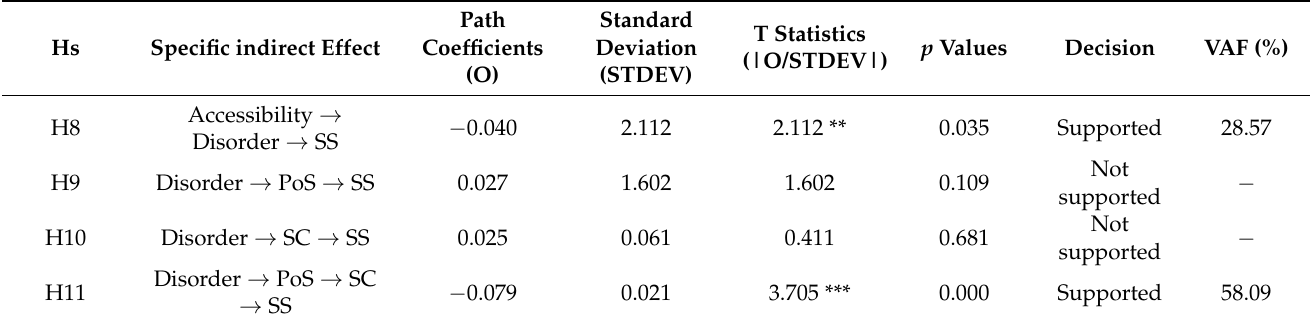
Table 5. Hypothesis testing (indirect